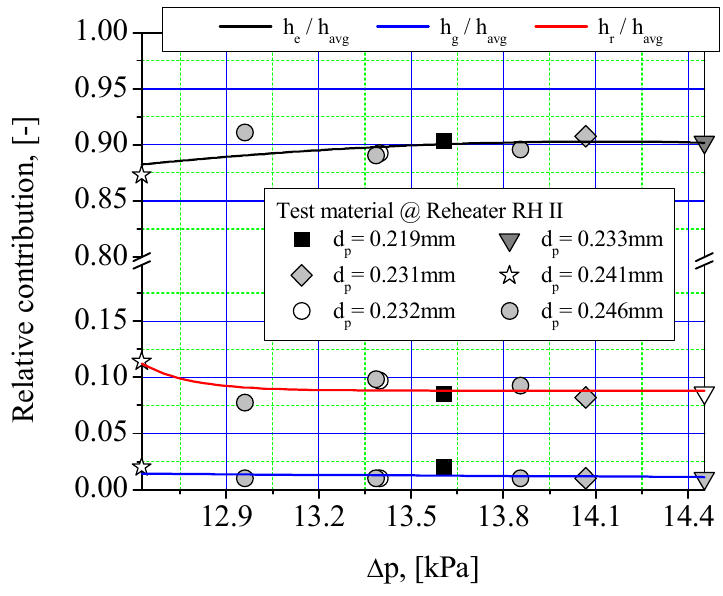
Figure 10. Heat transfer mechanisms variation with pressure drop.